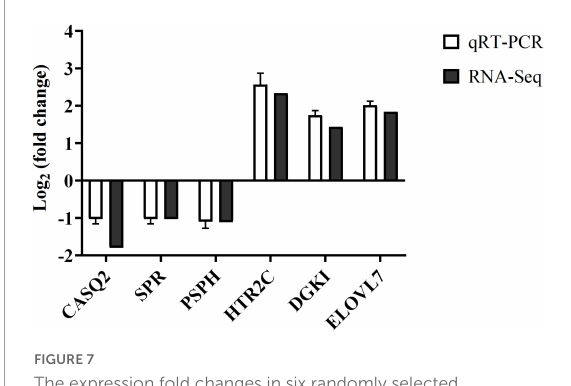
FIGURE7 The expression fold changes in six randomly selected differentially expressed genes (DEGs) between groups C and W of Landes geese based on the quantitative real-time PCR (qRT-PCR) analysis validating the expression patterns revealed by the RNA-Seq analysis. Group C, control group; Group W, added with 4% BSG in the all stage (days